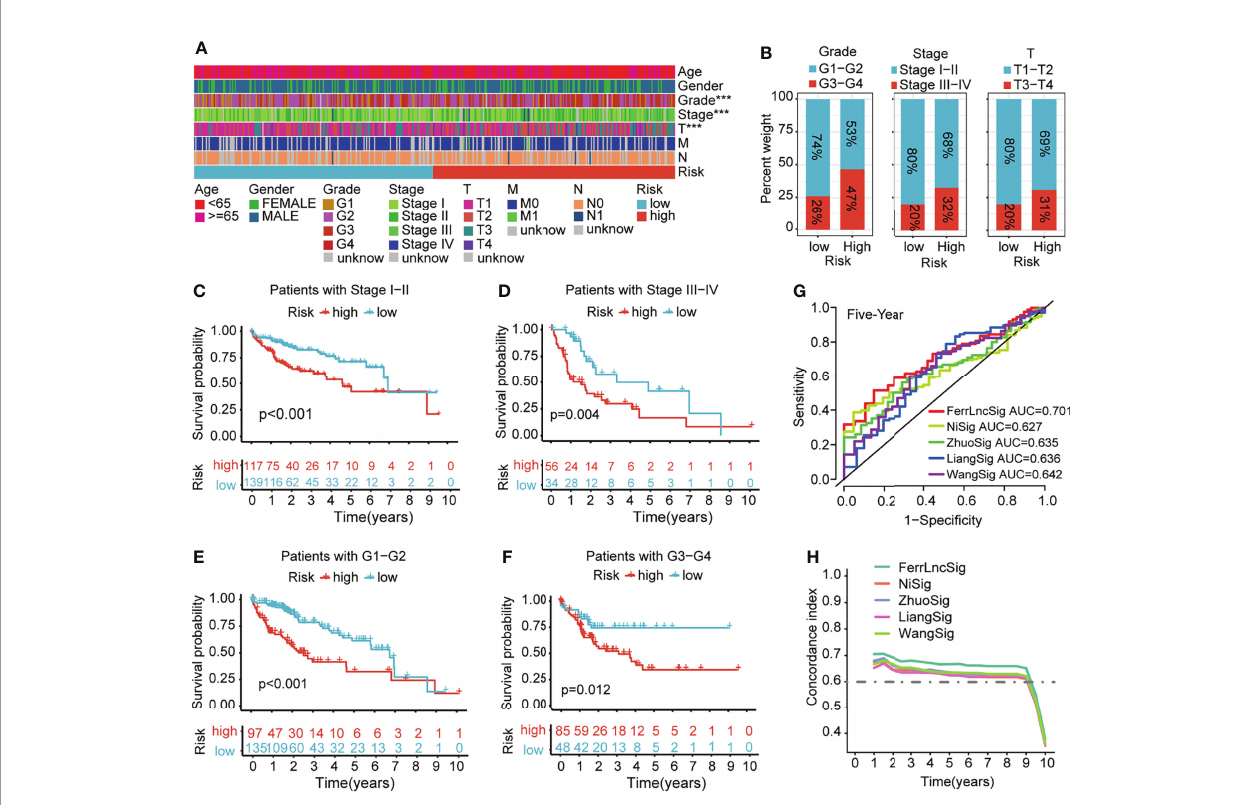
FIGURE 4 | Clinical relevance and model comparison. (A) Heatmap of correlations between prognostic signature and clinicopathological features. (B) Histograms showing the distribution of grade, stage, and T between the high- and low-risk groups. (C – F) Kaplan – Meier analyses of the signature strati fi ed by stage and grade. (G) Multivariate ROC curves of different HCC signatures to predict the sensitivity and speci fi city of 5-year survival. (H) Time-dependent c-index curve analysis of different HCC signatures. ROC, receiver operating characteristic; HCC, hepatocellular